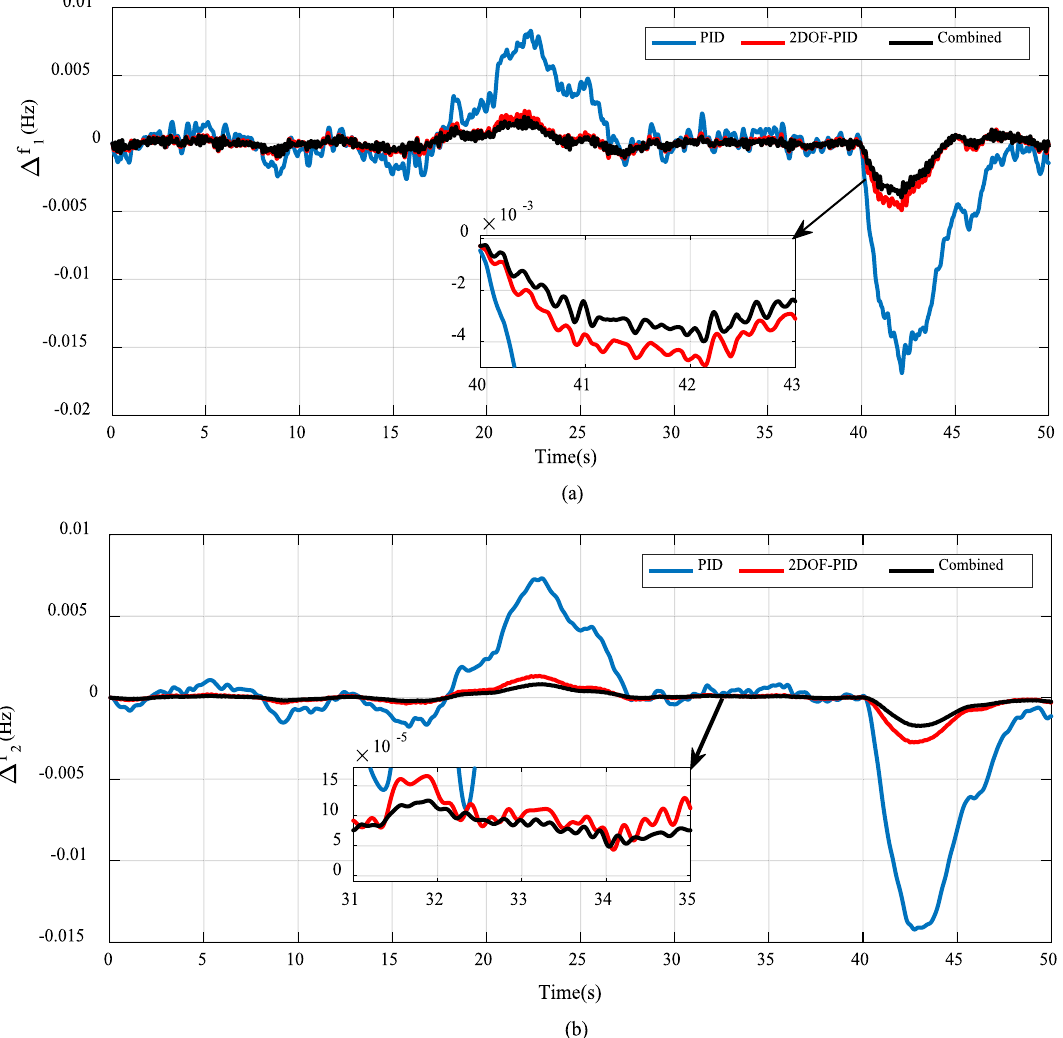
Fig. 7 Frequency disturbances generated during wind variations with secondary controllers (wind power variation in area I with 3% increase at 20 s and 6% decrease at 40 s without SLP). a Area I; b area